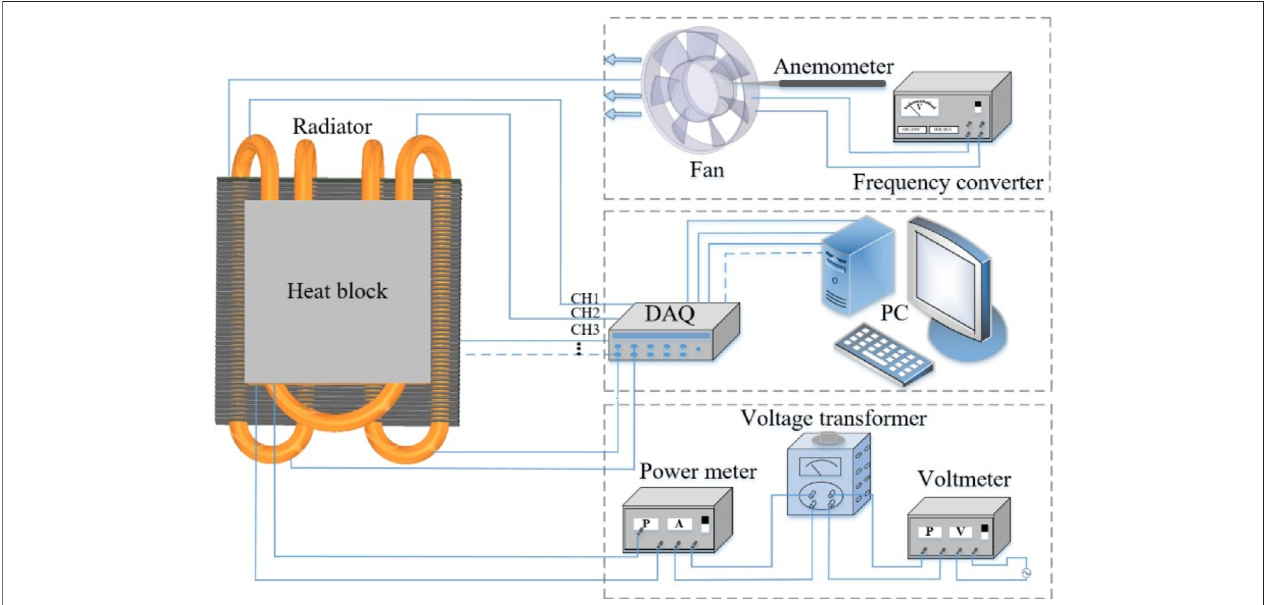
FIGURE 10 | Schematic diagram of a CPU cooler based on PHP (Shang et al., 2021).